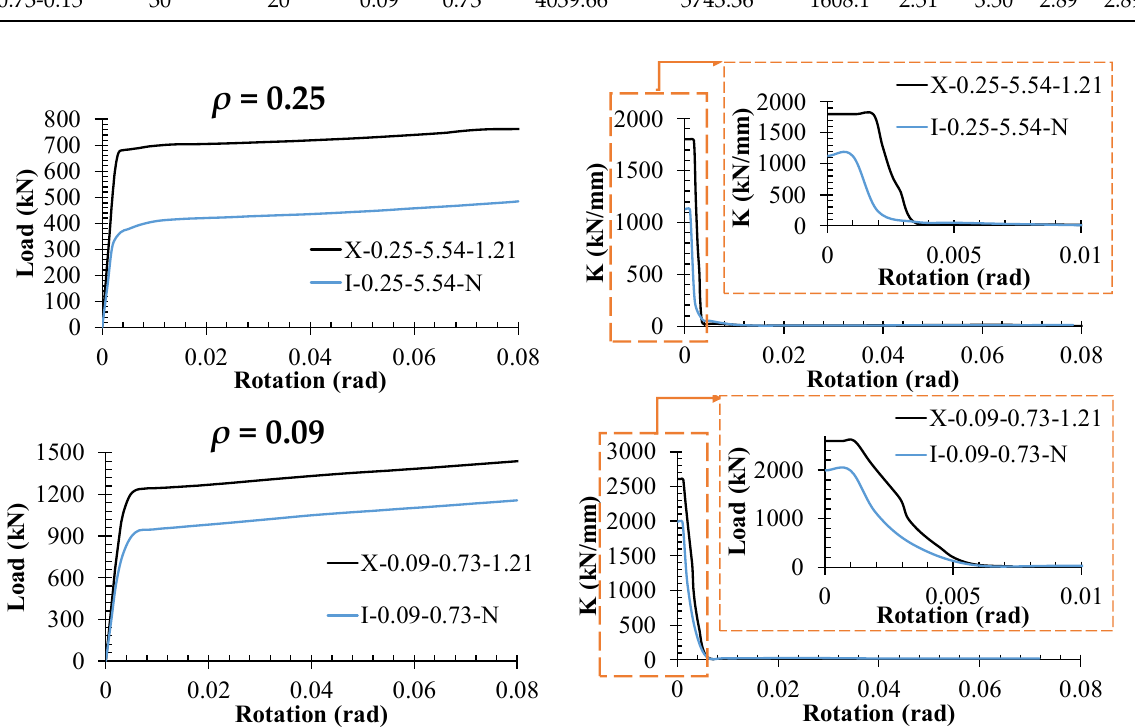
Figure 5. Comparing results of dampers with and without X-stiffeners (for dampers with ρ = 0.25 and ρ = 0.09). Table 2. Comparing results of damper with and without stiffeners.